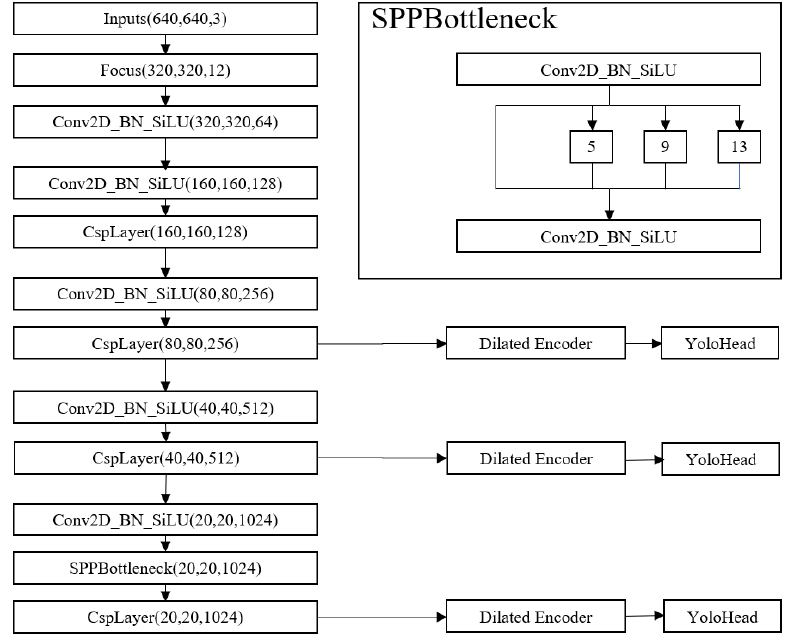
Figure 3. The structure of three one-level feature maps with feedback connection.